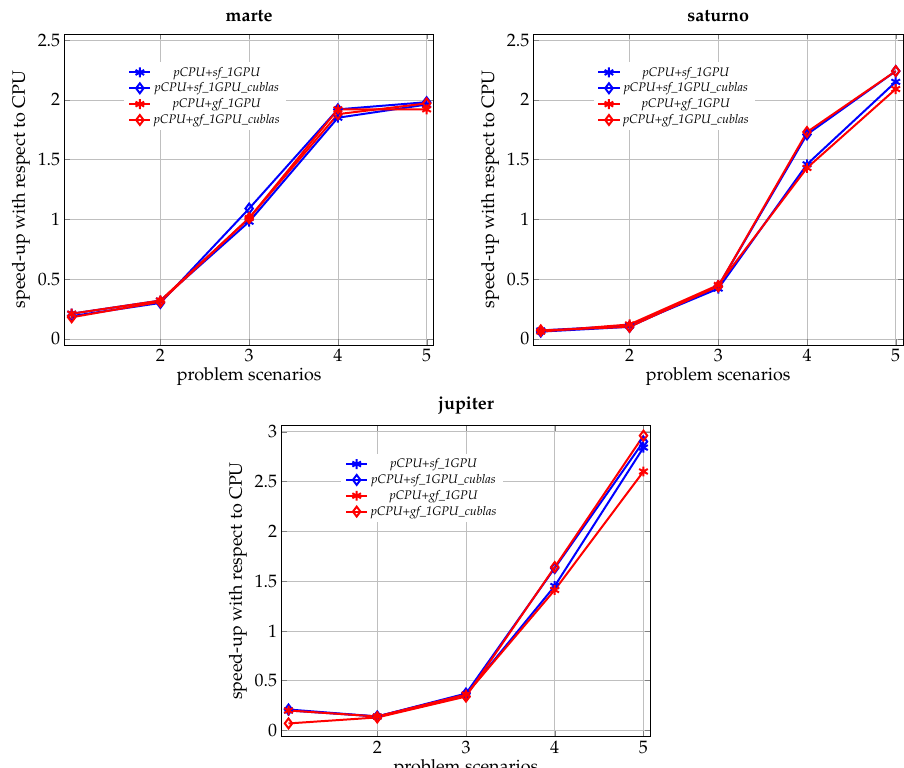
Figure 2. Speed-up with respect to the homogeneous parallel version on CPU ( pCPU ) of different hybrid versions using 1 GPU ( pCPU+xx_1GPU ), for different problem scenarios (Table 1); in the different